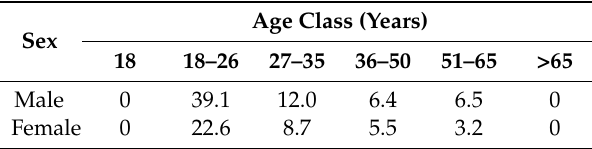
Table 6. Sample distribution (% of total) by sex and age classes.